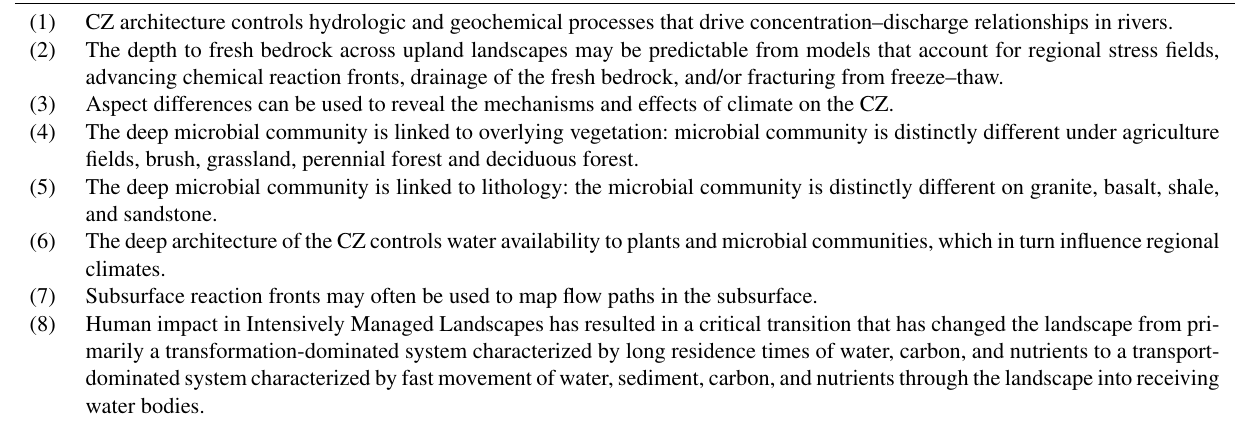
Table 4. A few emergent hypotheses from the CZO